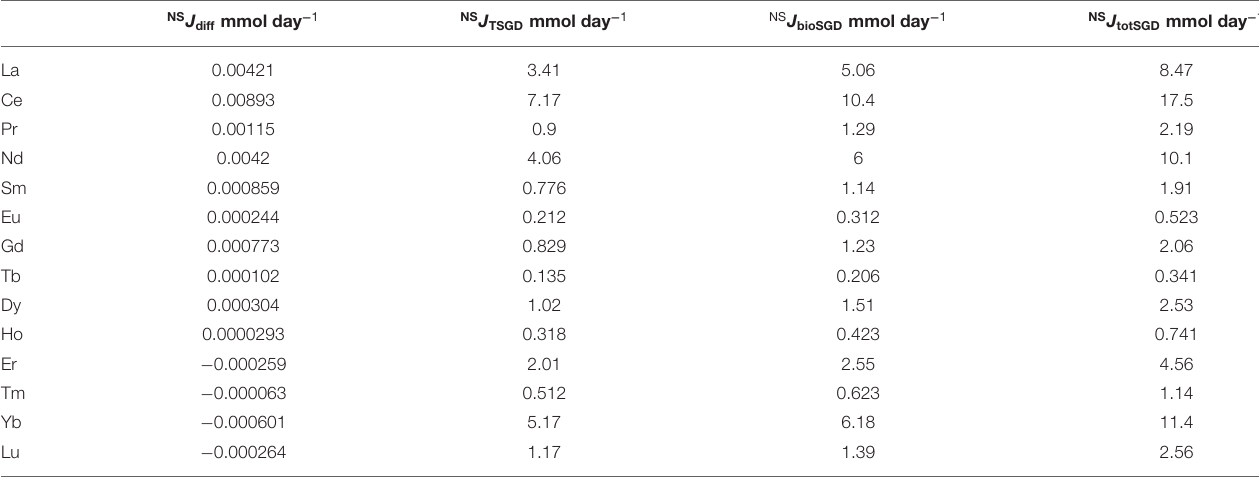
TABLE 3 | Computed SGD fluxes of the REEs across the nearshore transect (NS) of the Indian River Lagoon system ( Figure 1C